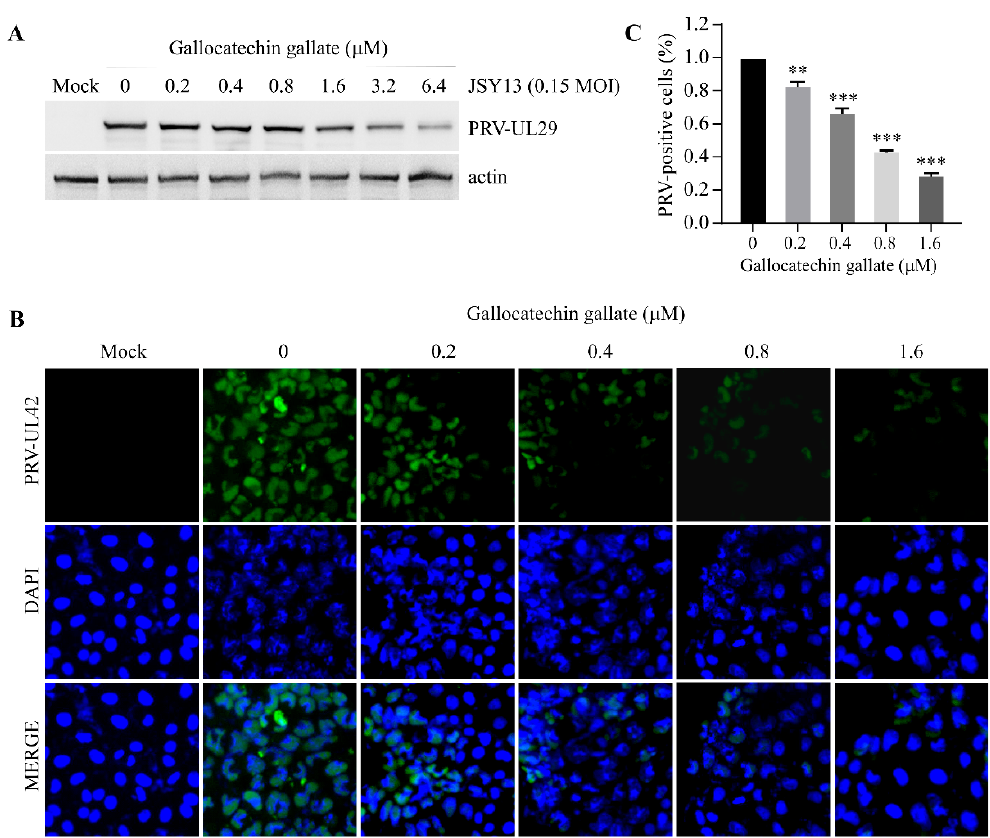
Figure 3. Gallocatechin gallate suppressed the replication of PRV in a dose-dependent manner. ( A ) Gallocatechin gallate could suppress the proliferation of PRV as shown by western-blot assay. PK15 cells were pretreated with 0.2 μ M, 0.4 μ M, 0.8 μ M, 1.6 μ M, 3.2 μ M, and 6.4 μ M gallocatechin gallate for 2 h, and the cells were infected with PRV-JSY13 (0.15 MOI) for 24 h. The cell samples were col- lected using 2 × SDS buffer and subjected to western blot assay. The expression levels of PRV-UL29 protein were analyzed by immunoblotting. ( B ) Gallocatechin gallate could suppress the prolifera- tion of PRV via IFA assay. PK15 cells were pretreated with 0.2 μ M, 0.4 μ M, 0.8 μ M, and 1.6 μ M gallocatechin gallate for 2 h, and then infected with JSY13 (0.15 MOI) for 18 h. After fixation and blocking, the cells were incubated with PRV-UL42 antibody and goat–anti-mouse secondary anti- body. Finally, the cells were stained with DAPI and captured with a U-HGLGPS microscope. ( C ) Graph shows the percentage of PRV-positive cells in experiment ( B ) from three independent exper- iments. (**, p < 0.01; ***, p < 0.001).